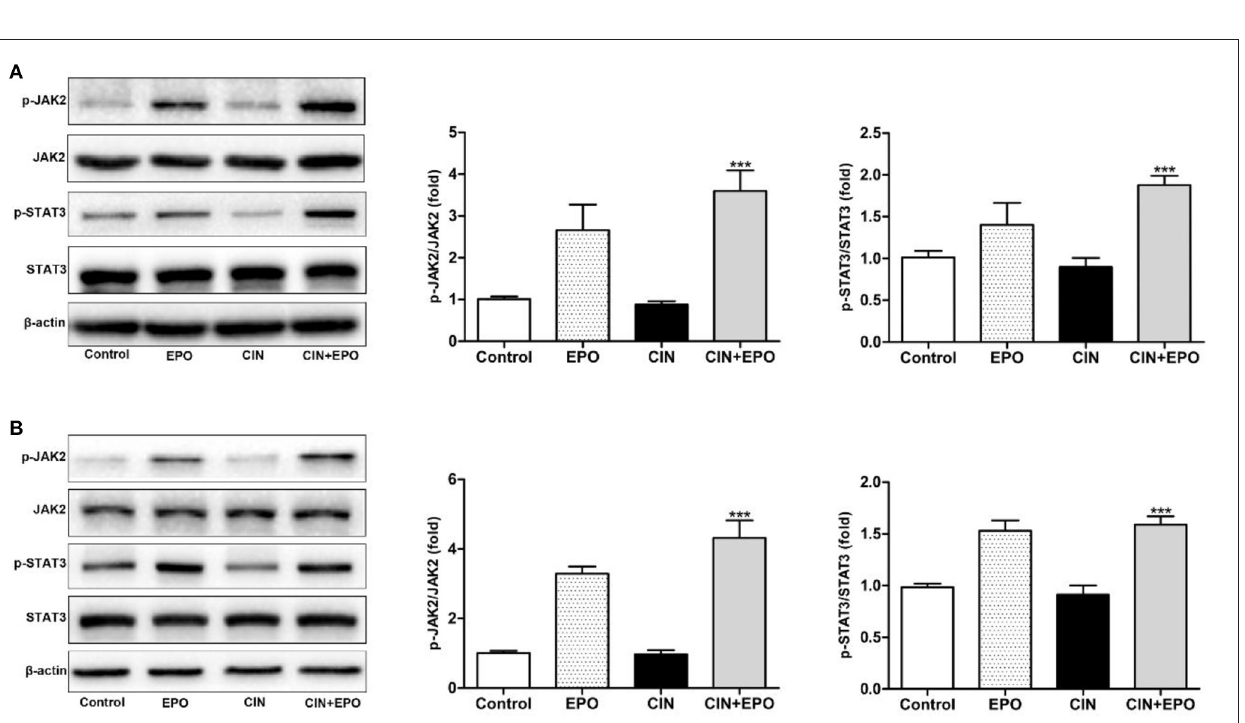
FIGURE 6 | Effect of EPO on protein levels of GSDMD and caspase-1 in mice (A) and HK-2 cells (B) . Values are expressed as the mean ± standard deviation ( n = 3). ** P < 0.01, *** P < 0.001 vs. the CIN group. # P < 0.05, ## P < 0.01 vs. the CIN group. EPO, erythropoietin; CIN, contrast-induced nephrology; GSDMD, gasdermin D.